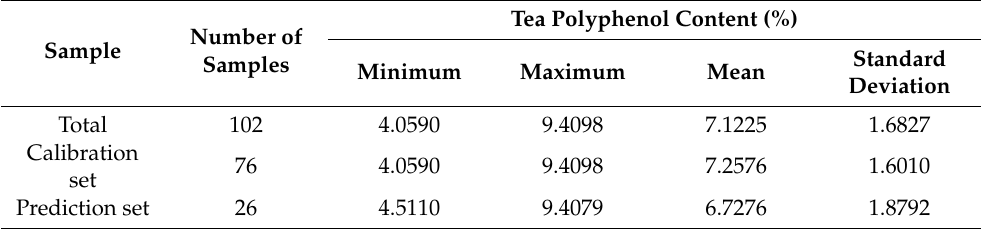
Table 1. Tea polyphenol content statistics and sample partition results based on the SPXY